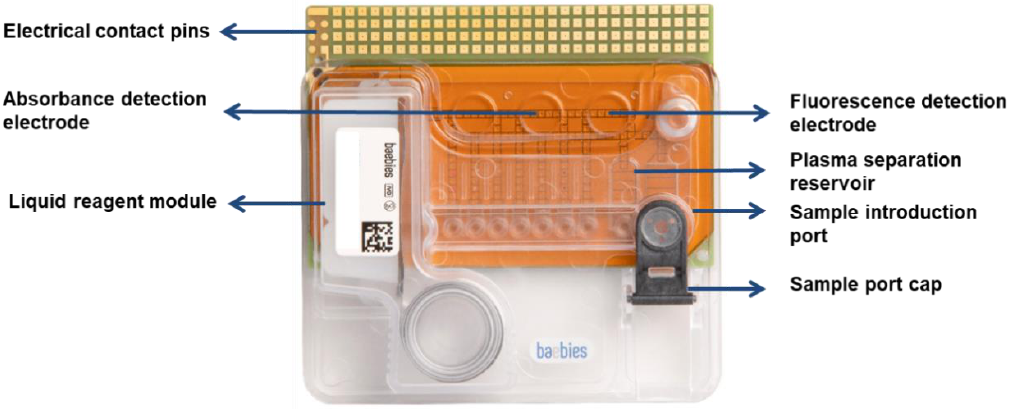
Figure 2. The single-use cartridge is comprised of a printed circuit board and a plastic top plate. Notable features include the sealed liquid reagent module, sample loading port, and dried reagents (not shown).